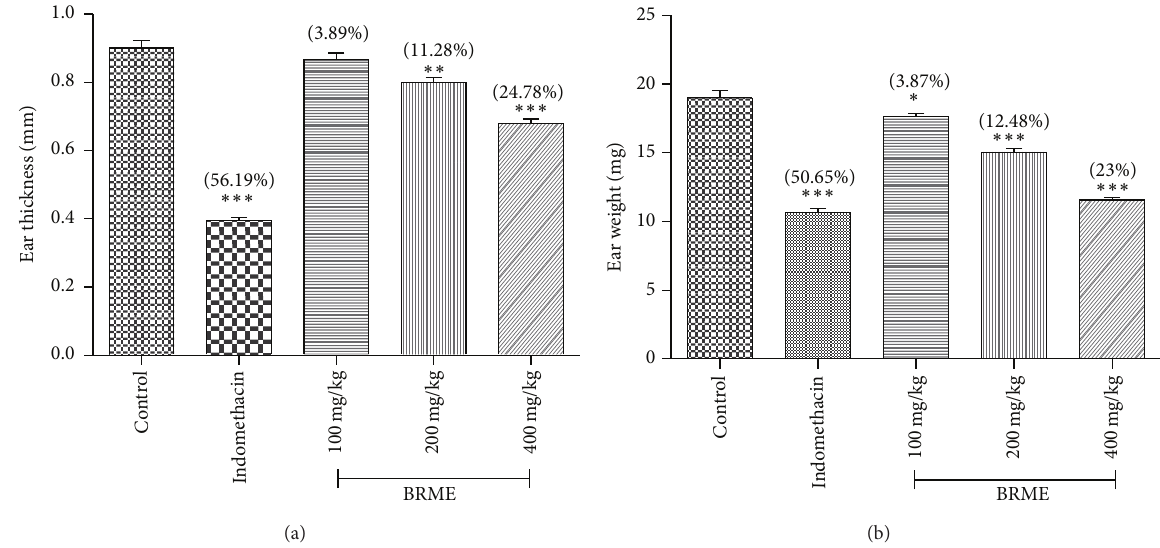
Figure 4: Effect of BRME and indomethacin on TPA-induced ear thickness (a) and ear weight (b). Values are expressed as means ± SEM ( 𝑛 = 6 ). ∗ 𝑃 < 0.05 , ∗∗ 𝑃 < 0.01 , and ∗∗∗ 𝑃 < 0.001 compared to the controls (one-way ANOVA followed by Dennett’s test). (%) represents percentage inhibition of oedema development.